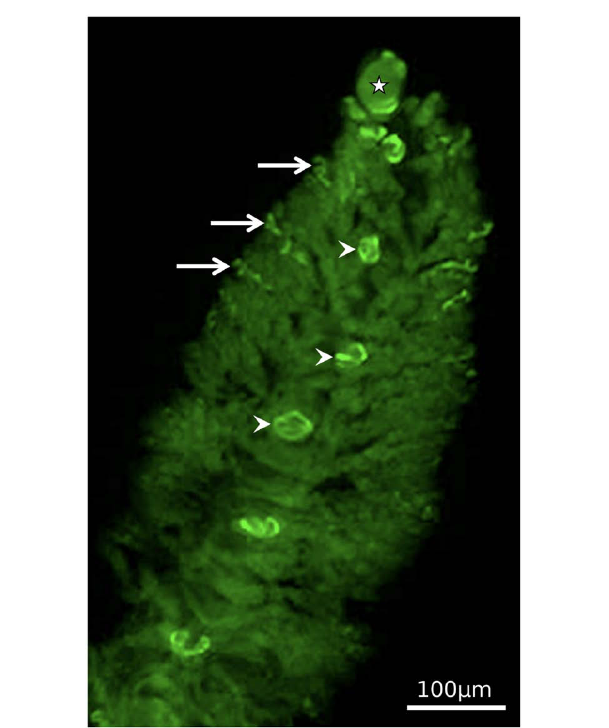
the base of the branches, macrozooids are produced. The num-